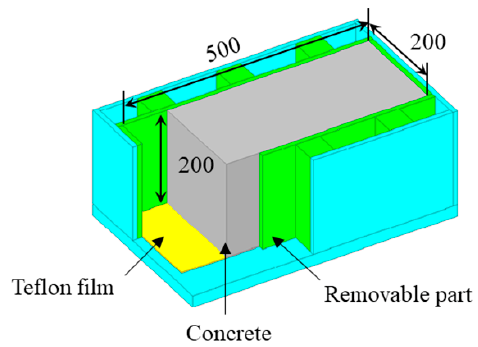
Figure 1. Teflon mold for forming specimens (All dimensions are in mm).